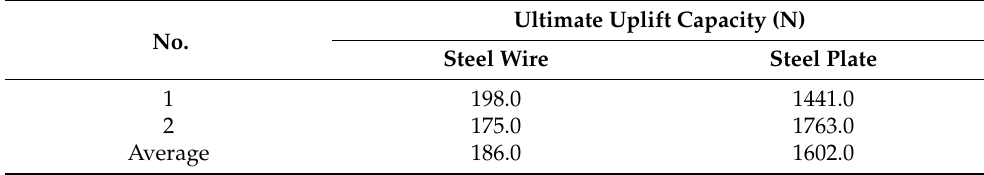
Table 7. Ultimate uplift capacity according to pipe connector type [23].